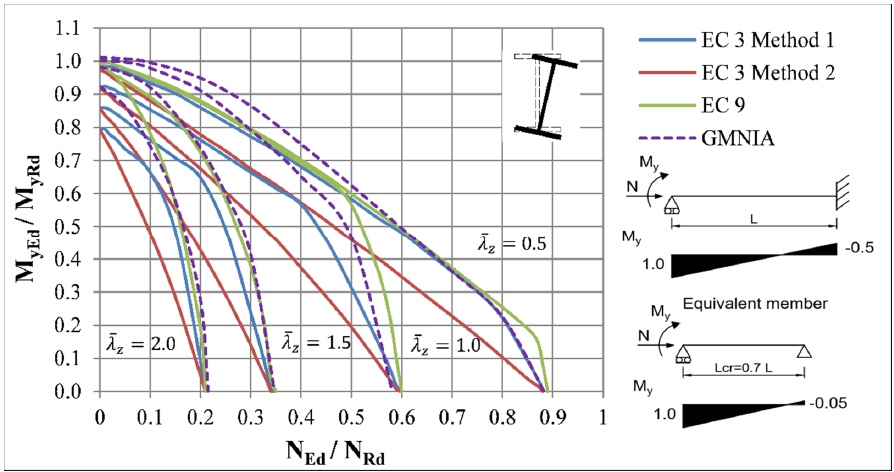
Figure 21. Interaction curves for laterally unrestrained beam-columns with IPE 100 cross-section with free warping.